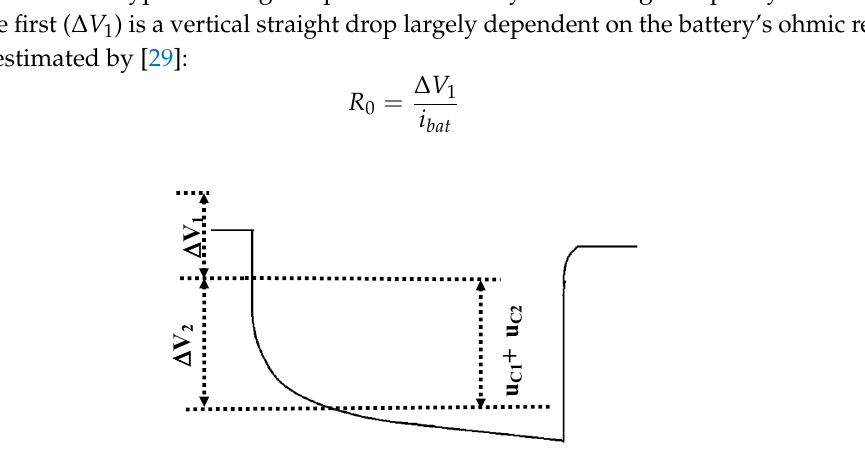
Figure 5. Single pulse of voltage response.